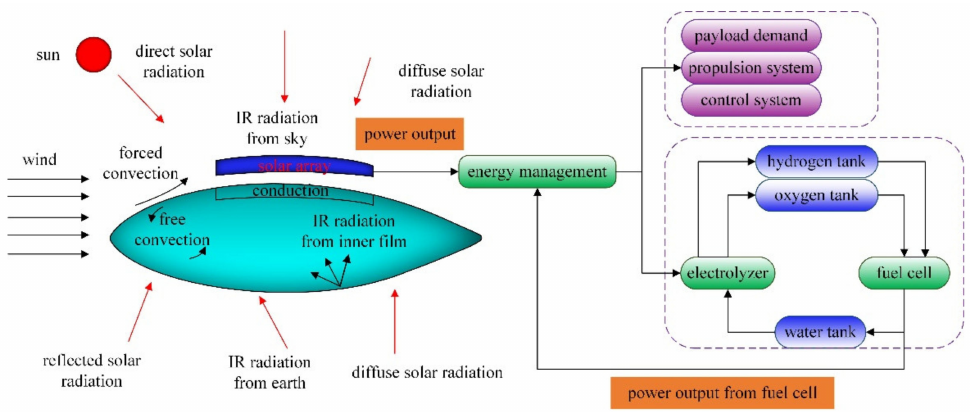
Figure 1. Thermal-electric coupled process of